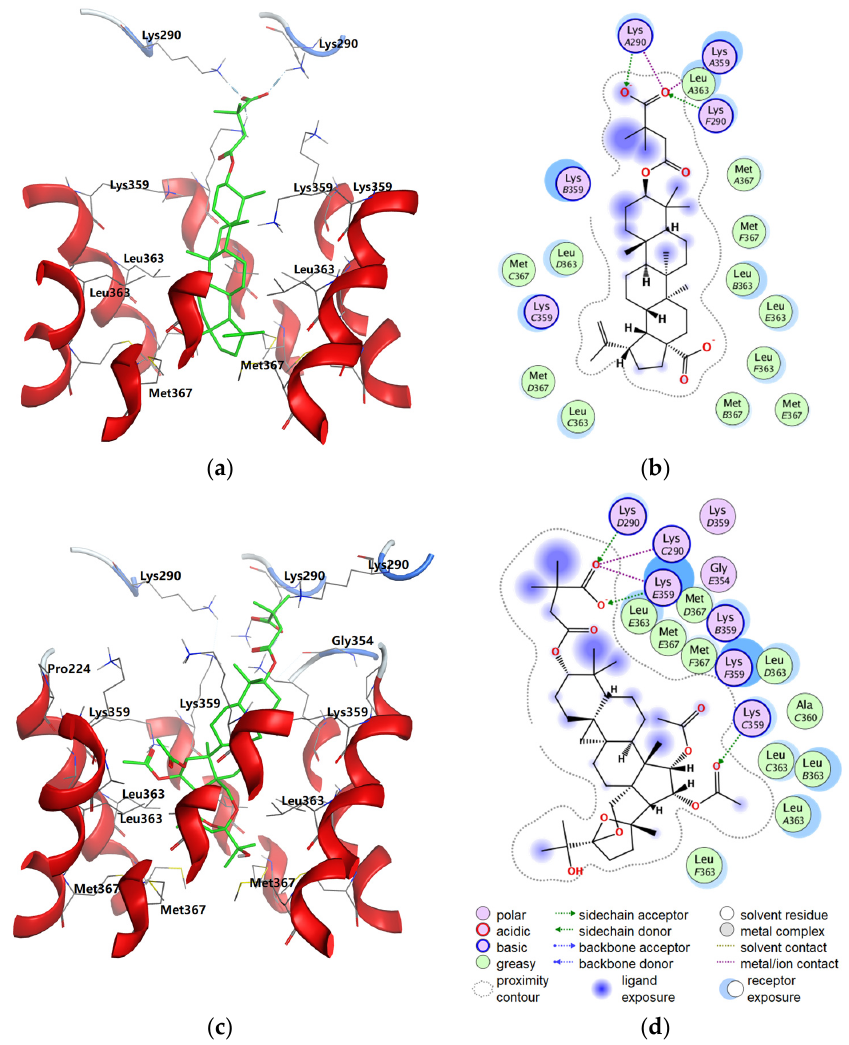
Figure 5. Binding model and interaction of BVM ( a , b ) and DSC ( c,d ).